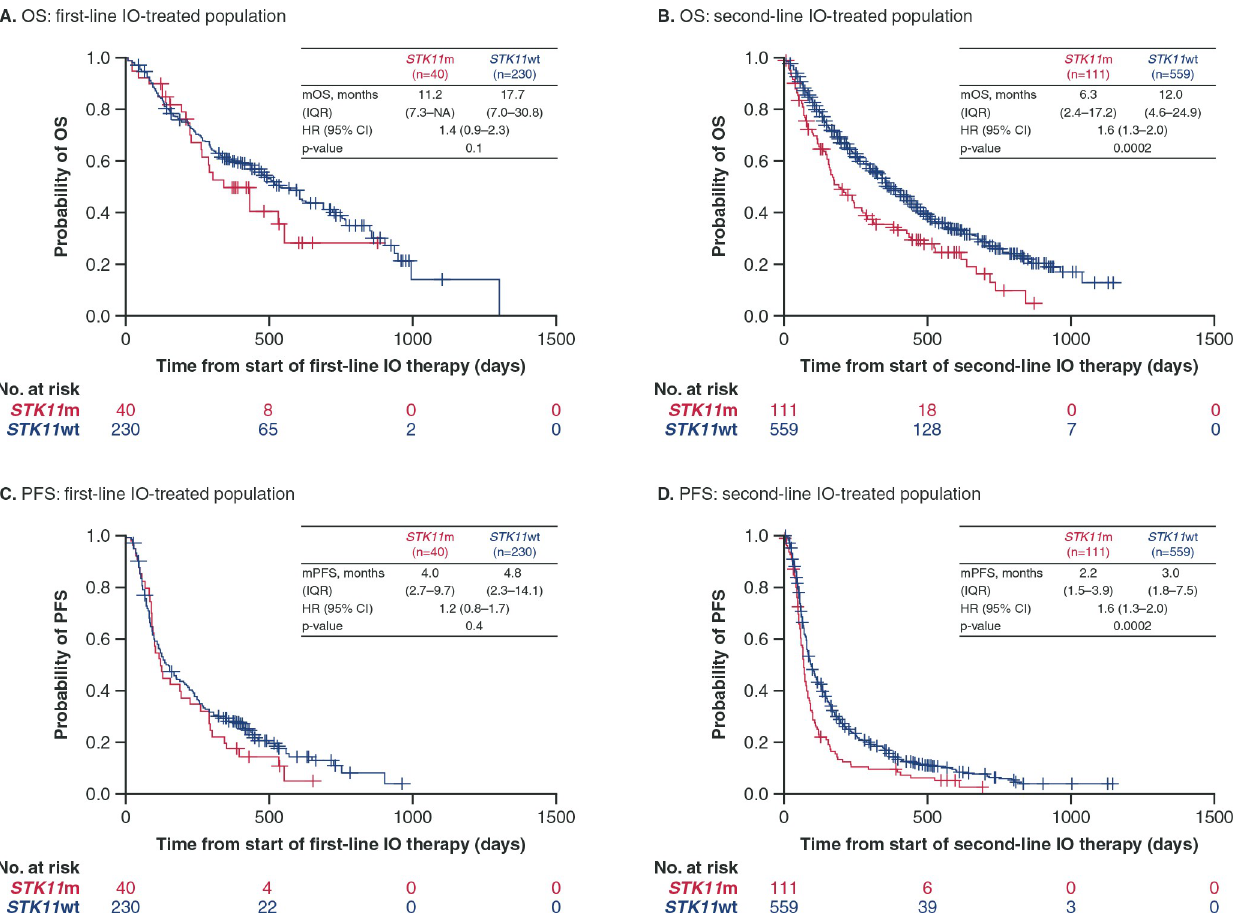
Fig 1. Overall survival and progression-free survival from start of first-line and second-line IO by STK11 mutation status. OS and PFS were assessed as time to event from initiation of line of therapy (first-line or second-line). HR values reported are adjusted HRs calculated using multivariate Cox regression models (variables in the final adjusted multivariate analysis in the first-line IO group included race, ECOG status � 60 days before start of line 1, and stage at initial diagnosis for OS [panel A ] and ALK status for PFS [panel C ]; for the second-line IO group, ECOG status � 60 days before start of line 2 was included for OS and PFS [panels B and D ]). CI: confidence interval; ECOG: Eastern Cooperative Oncology Group; HR: hazard ratio; IO: immunotherapy; IQR: interquartile range; OS: overall survival; PFS: progression-free survival.